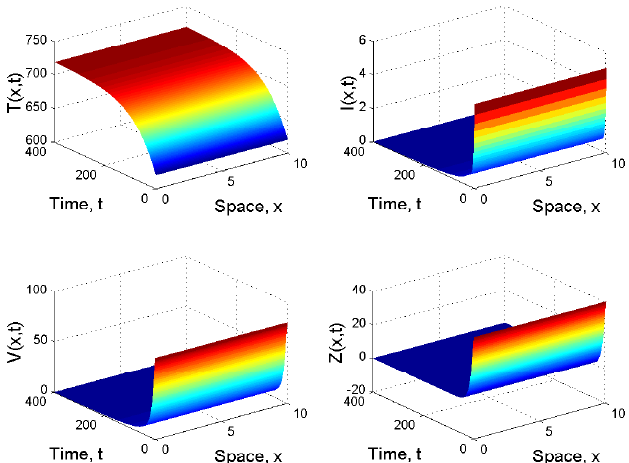
Figure 1. Spatiotemporal dynamics of the model (21) when R 0 = 0.8539 ≤ 1.